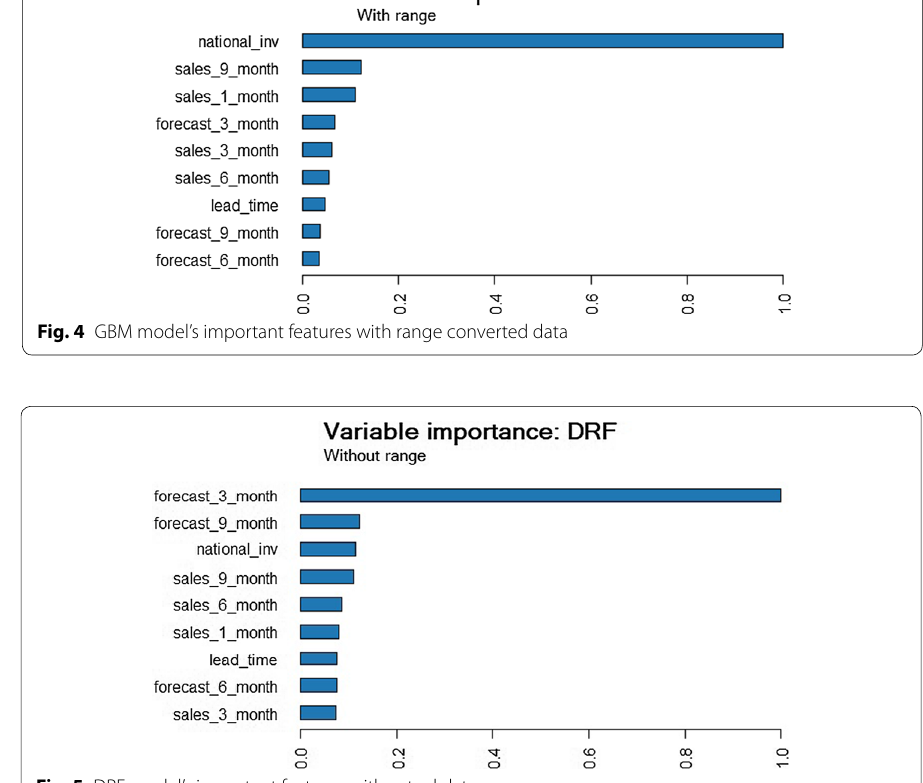
Fig. 5 DRF model’s important features with actual